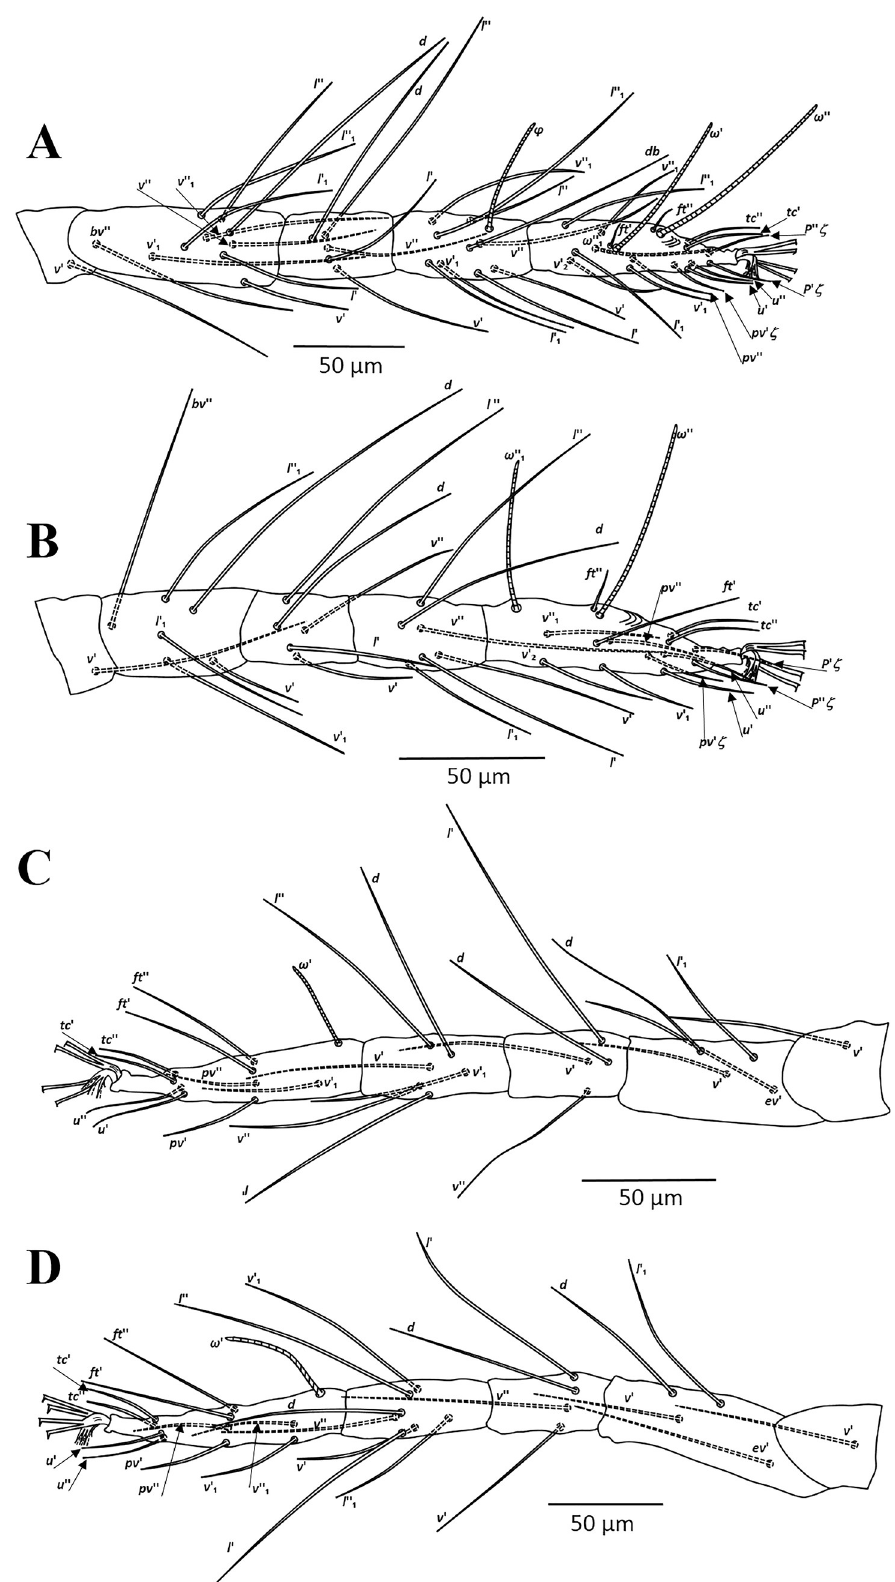
Fig 2. Amphitetranychus quercivorus , female—A. Leg I, B. Leg II, C. Leg III, D. Leg IV.